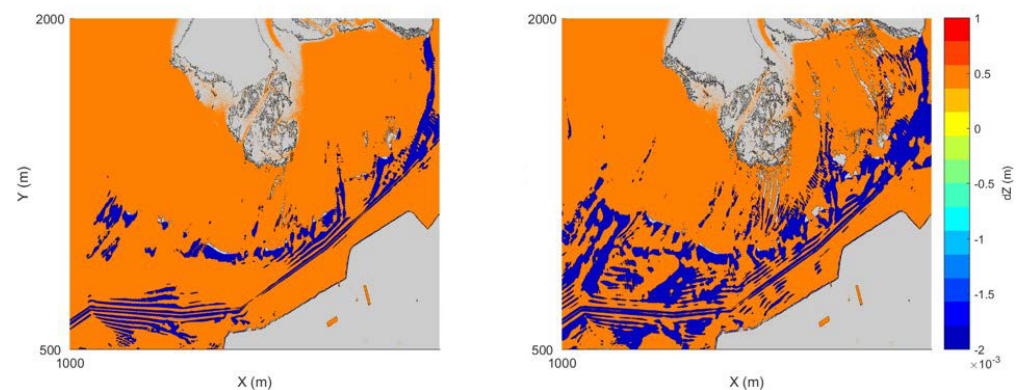
Figure 8. Spatial distribution of cumulative wake-induced bed elevation changes after the passage of 10 small (left panel) and 10 large (right panel) vessels. The vessel sailing speed is 15 knots.